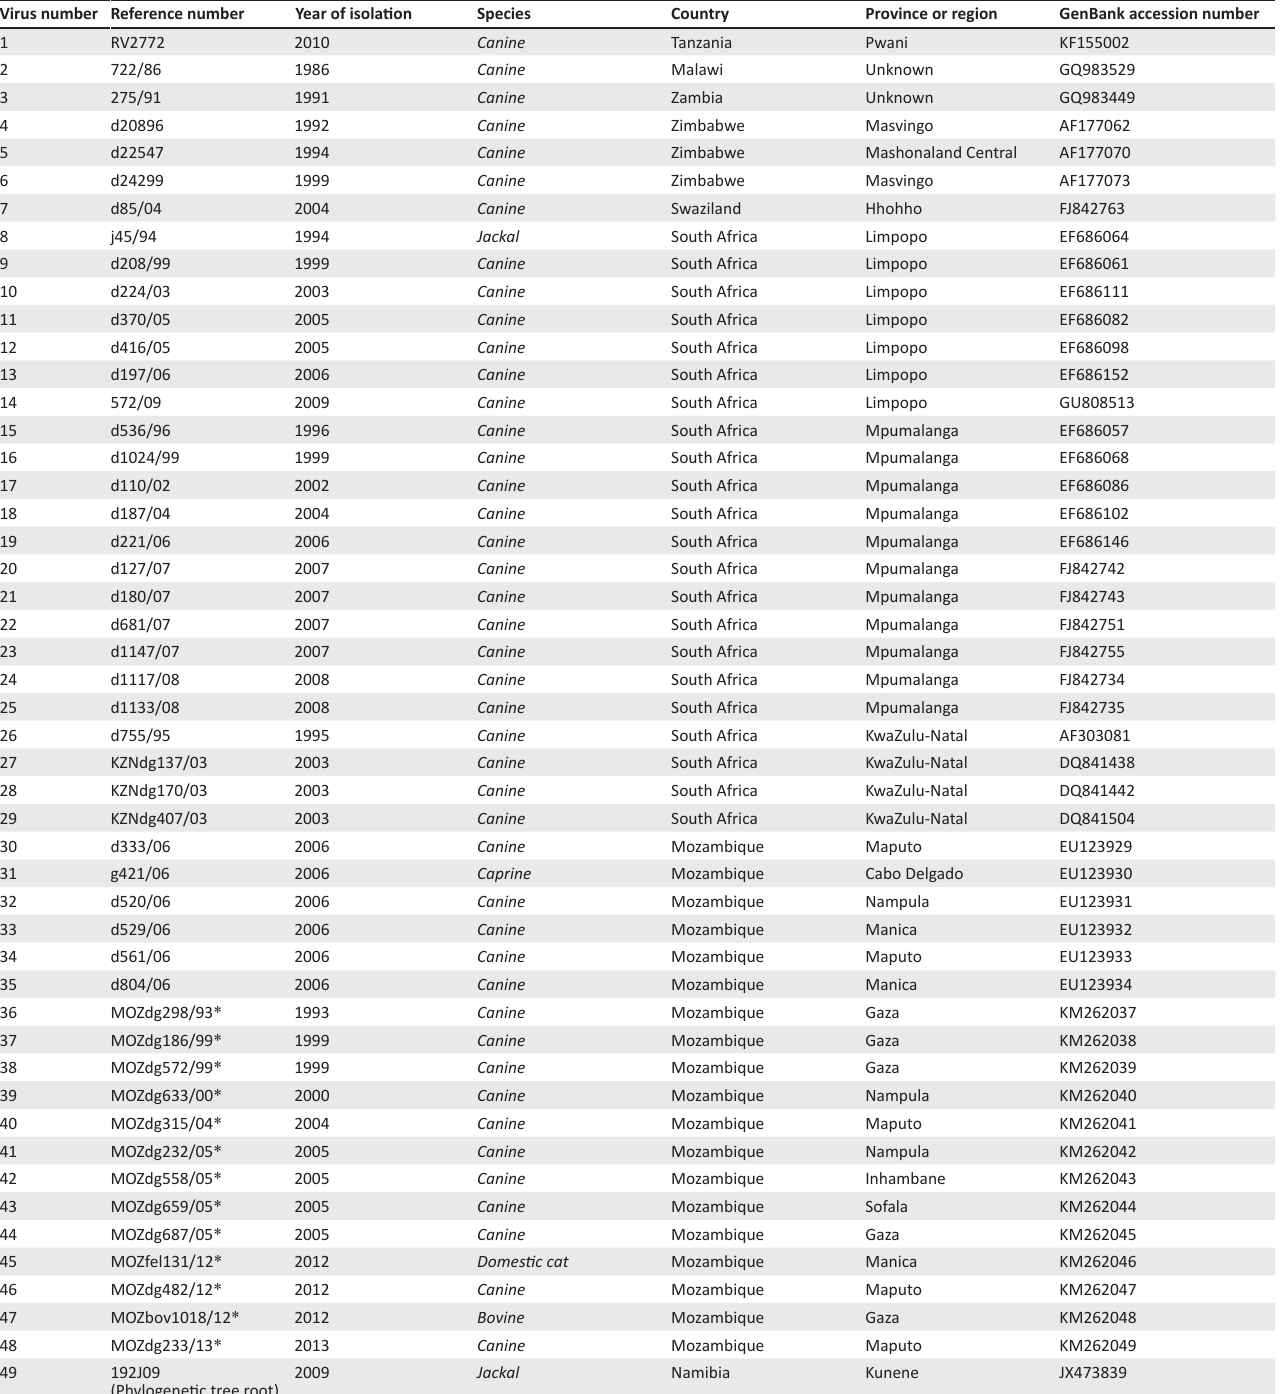
TABLE 2: Panel of rabies viruses from Mozambique and neighbouring countries included in the phylogenetic analysis performed in this study. Virus number Reference